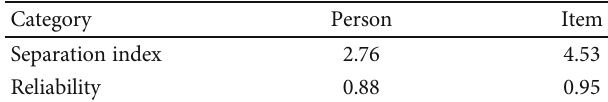
Table 3: Person and item separation